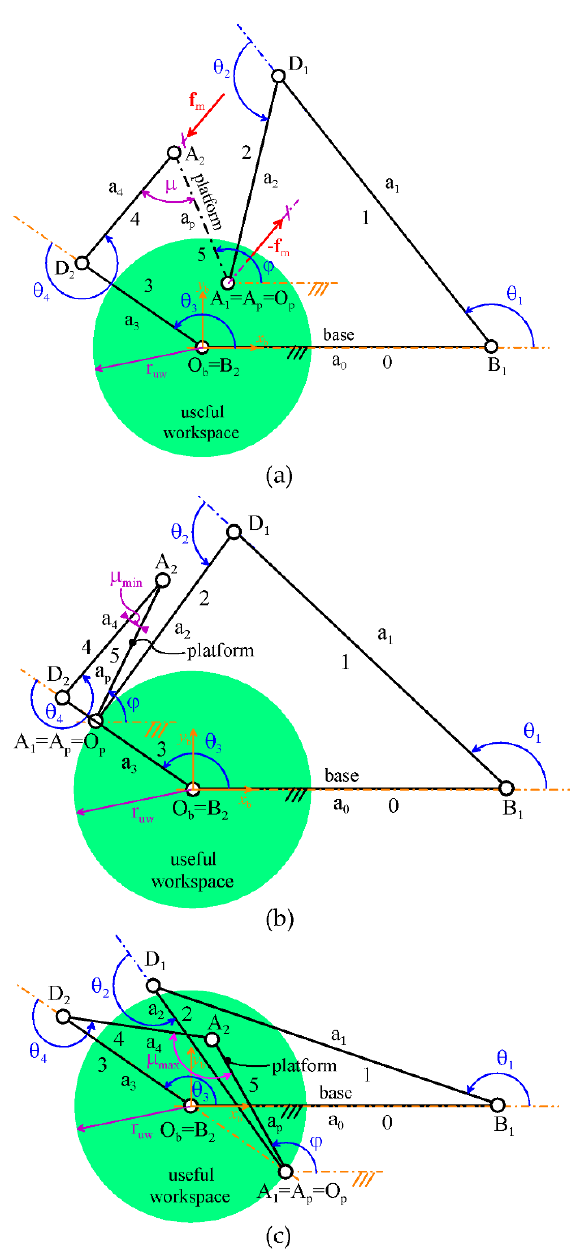
Figure 5. Top view of the studied LaMaViP’s CRS-RRC: ( a ) external loads applied to the limbs in the case M e,z = 1 Nm, ( b ) a mechanism configuration with the minimum value of µ , ( c ) a mechanism configuration with the maximum value of µ